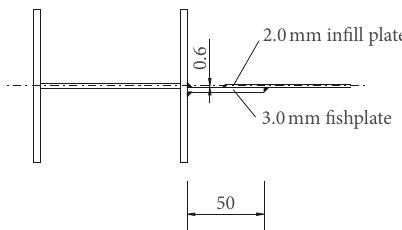
Figure 2: Details of the fishplate (units: